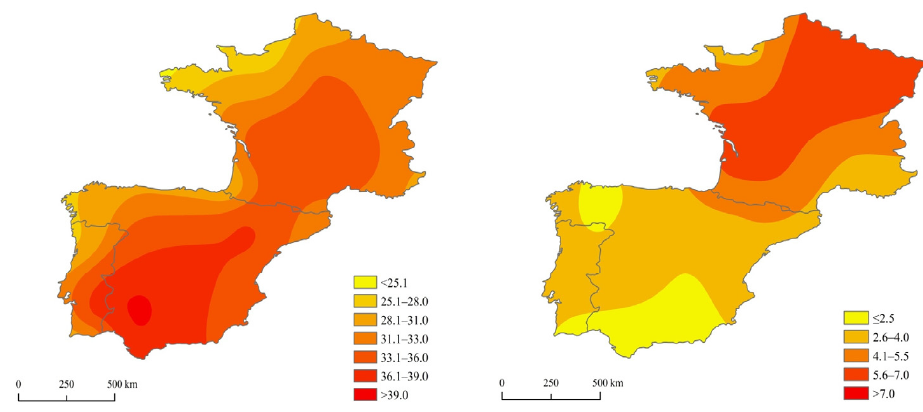
Figure 12. The mean Tmax and Tmax anomalies in the period between 10 and 28 July 2006. During the HW of 2006, the centres of positive both z500 hPa and SLP anomalies were located over the North Sea, exceeding 145 m and 7 hPa, respectively. In consequence, a local anticyclone formed in this region, exceeding 1021 hPa in the centre (Figure 13).